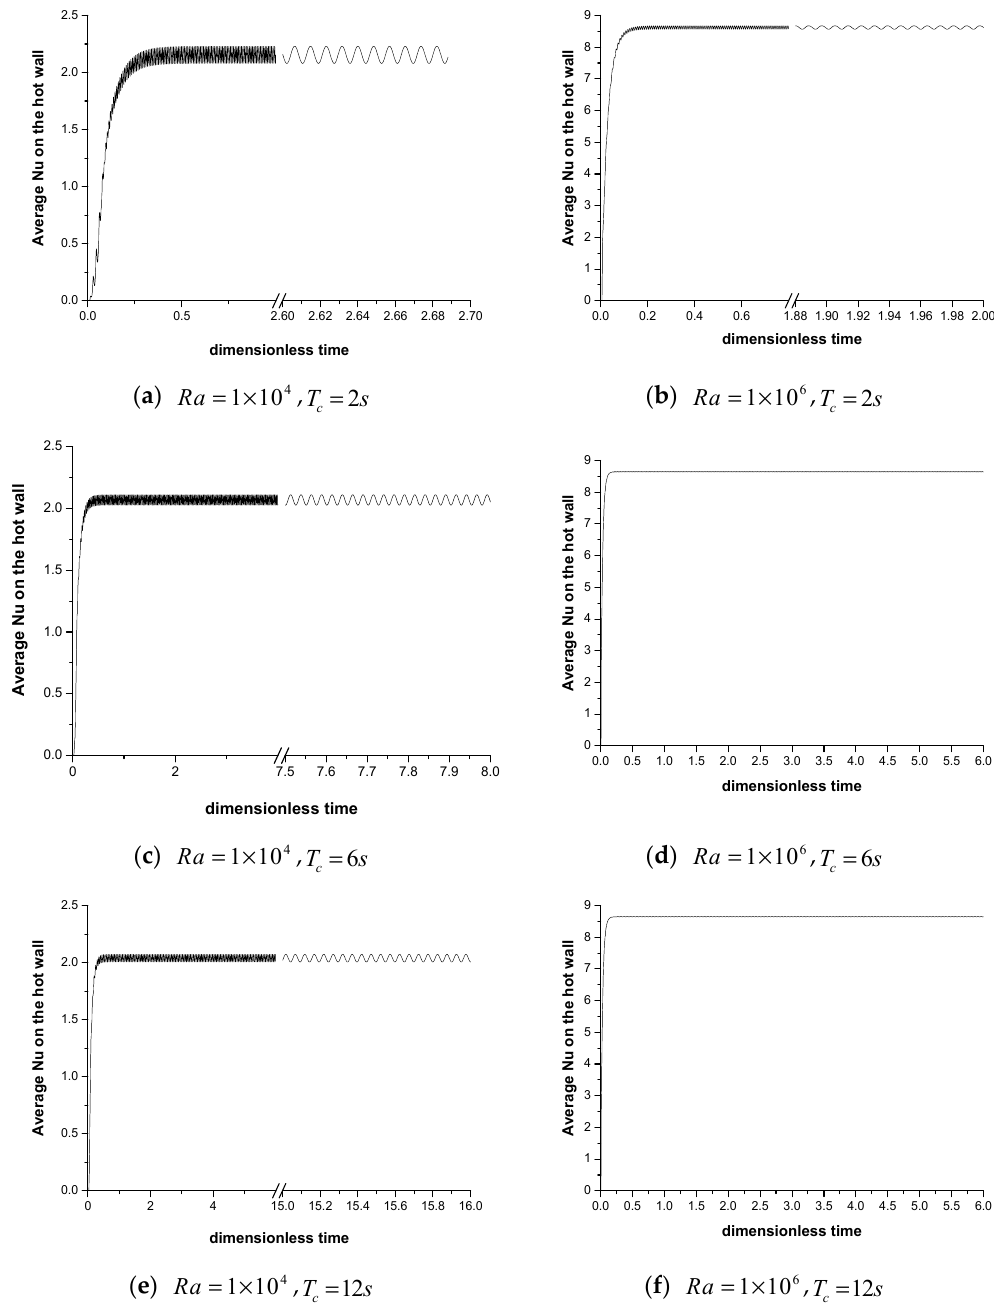
Figure 18. Average Nu on the hot face under di ff erent cases at ϕ m = π /8: ( a ) Ra = 1 × 10 4 , T c = 2 s ; ( b ) Ra = 1 × 10 6 , T c = 2 s ; ( c ) Ra = 1 × 10 4 , T c = 6 s ; ( d ) Ra = 1 × 10 6 , T c = 6 s ; ( e ) Ra = 1 × 10 4 , T c = 12 s ; ( f ) Ra = 1 × 10 6 , T c = 12 s